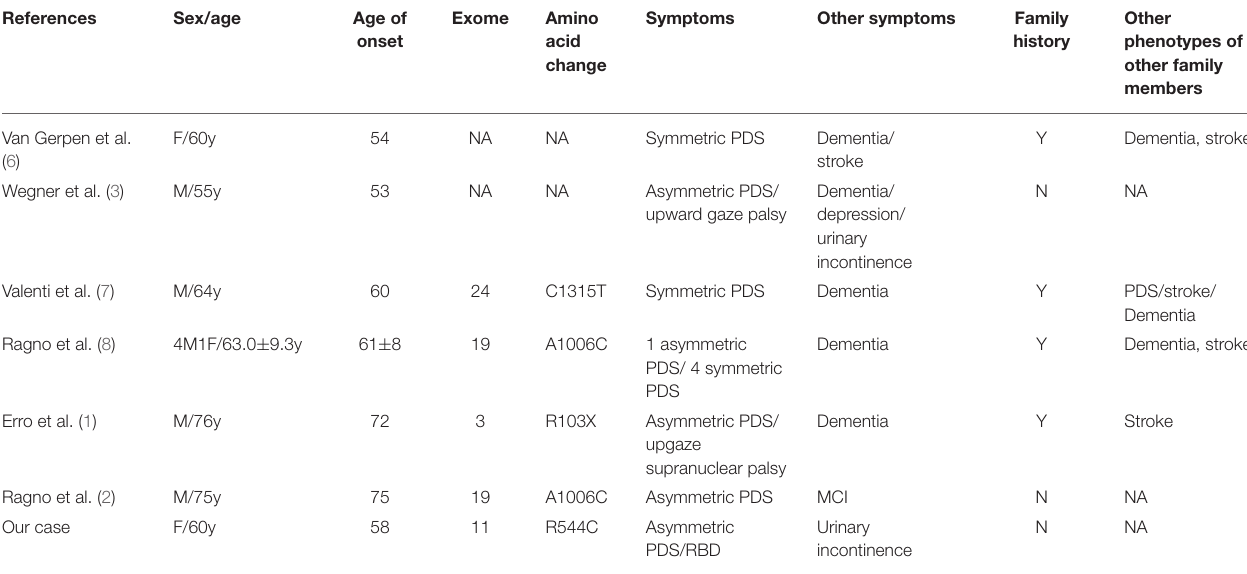
TABLE 1 | Clinical manifestation of previous reported CADASIL with